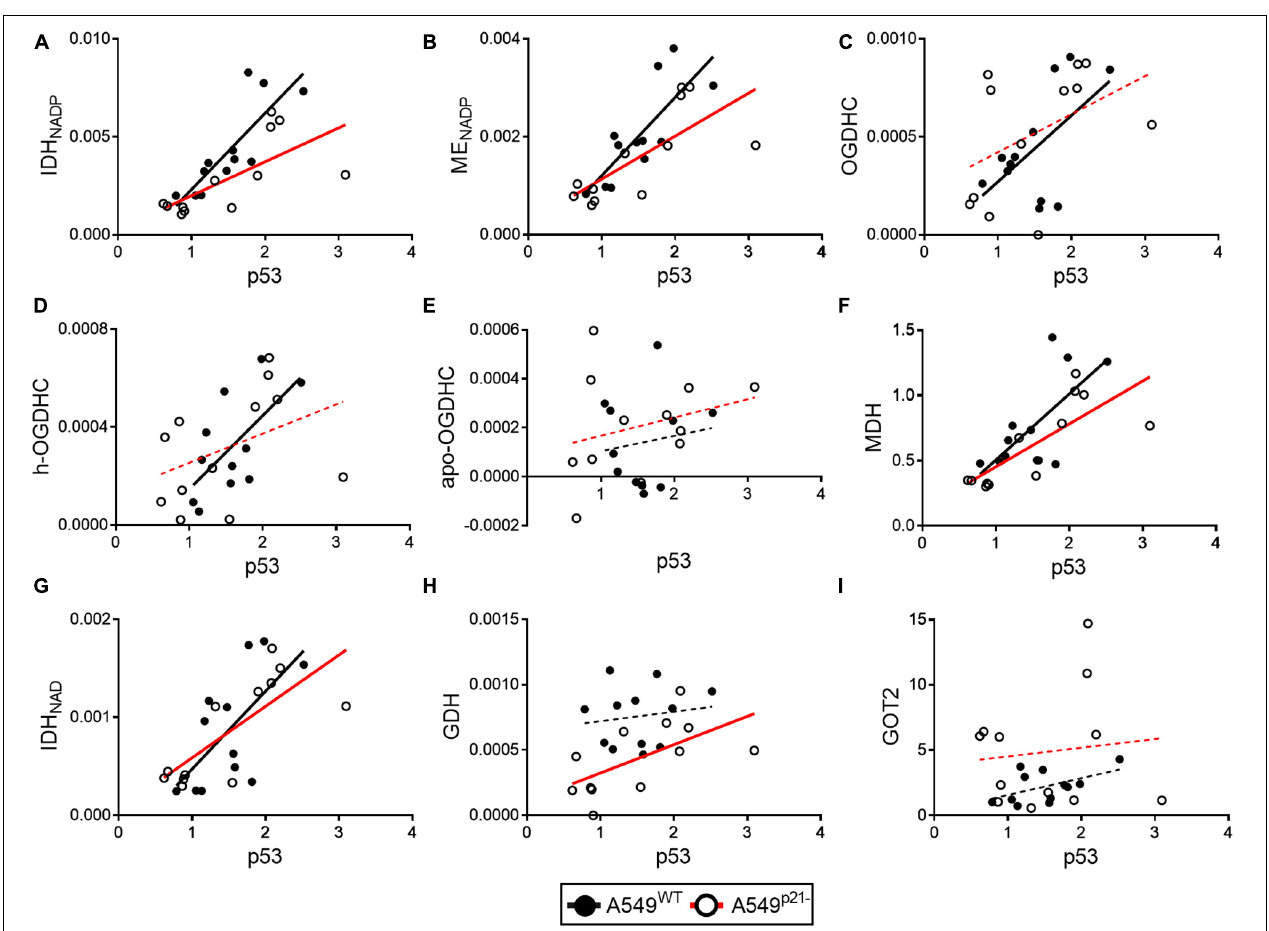
FIGURE 5 | Changes in correlations between the levels of p53 and studied enzymes in A549 WT and A549 p21 − cells. Levels of p53 protein (horizontal axes) are correlated to activities or expression of the enzymes, indicated on the graphs (vertical axes). (A–H) Enzyme activities are shown in µ mol · min − 1 · mg − 1 ; protein levels of the mitochondrial aspartate aminotransferase (GOT2) (I) and p53 are indicated in arbitrary units. OGDHC—total OGDHC activity, h-OGDHC—activity of holo-OGDHC, assayed at endogenous level of ThDP, apo-OGDHC—ThDP-free (not active) OGDHC, determined as the difference between the activities of the total and holo-OGDHC. Linear regressions of Pearson’s correlations are presented by black (A549 WT ) or red (A549 p21 − ) lines, which are solid ( p < 0.05) or dashed ( p > 0.05) depending on the P -values of the correlation significance. Each point represents a separate cell culture from the three independent